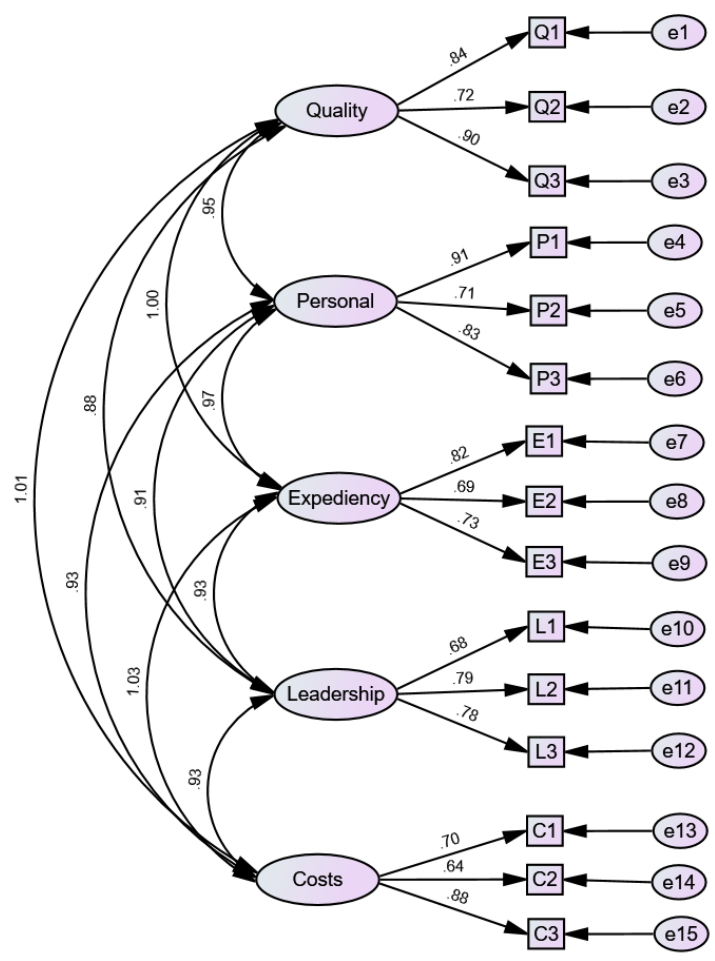
Figure 1. Confirmatory factor analysis (Correlated Factor Model). Source: authors’ results.